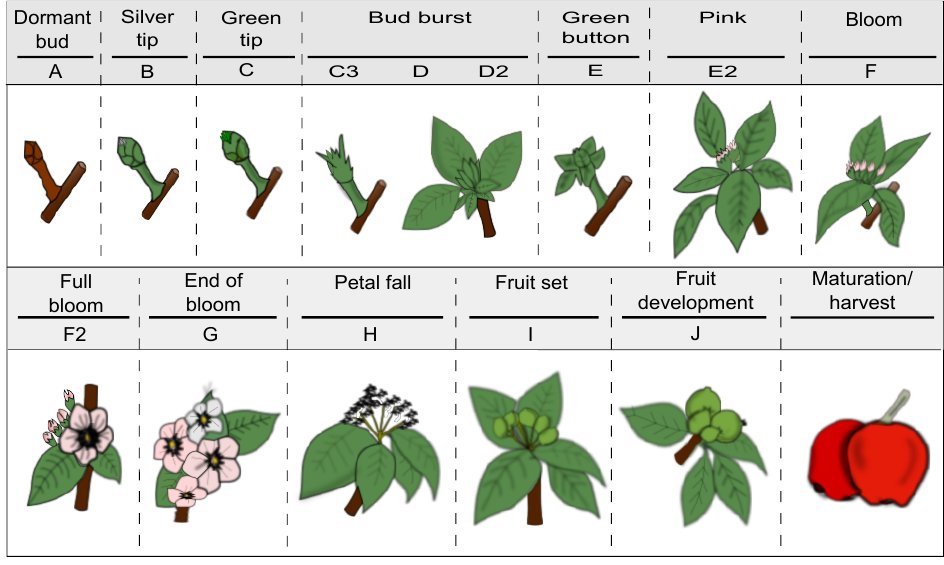
Figure 1. Apple phenologial